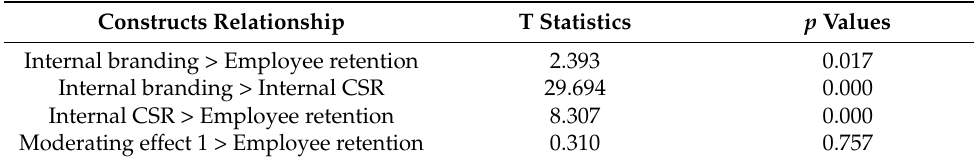
Table 4. The implication of